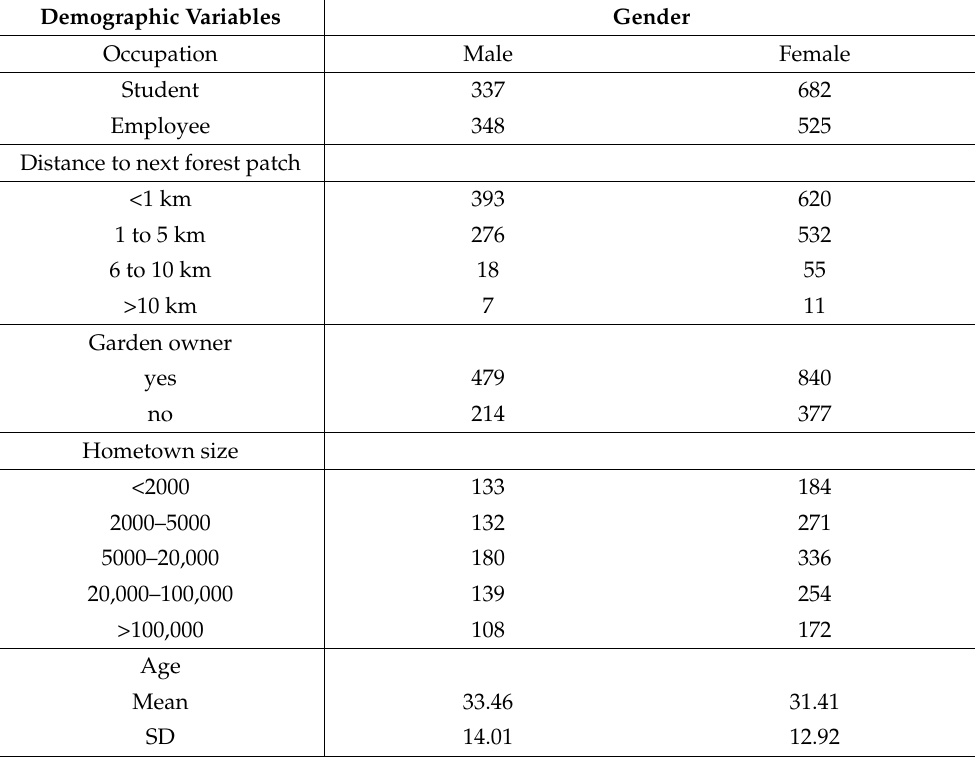
Table 1. Sample characteristics split according to